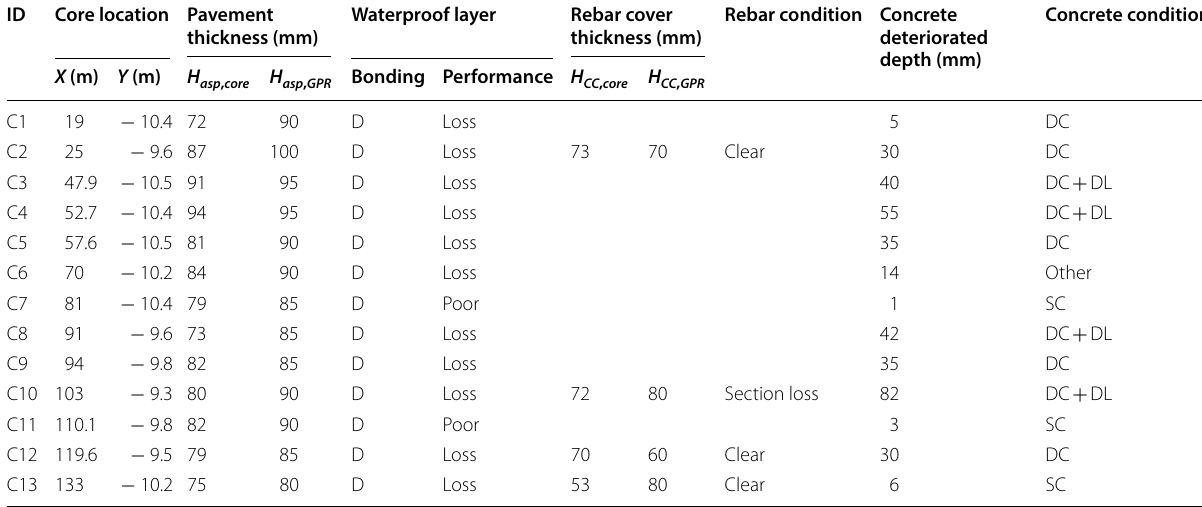
Table 3 Summary of core